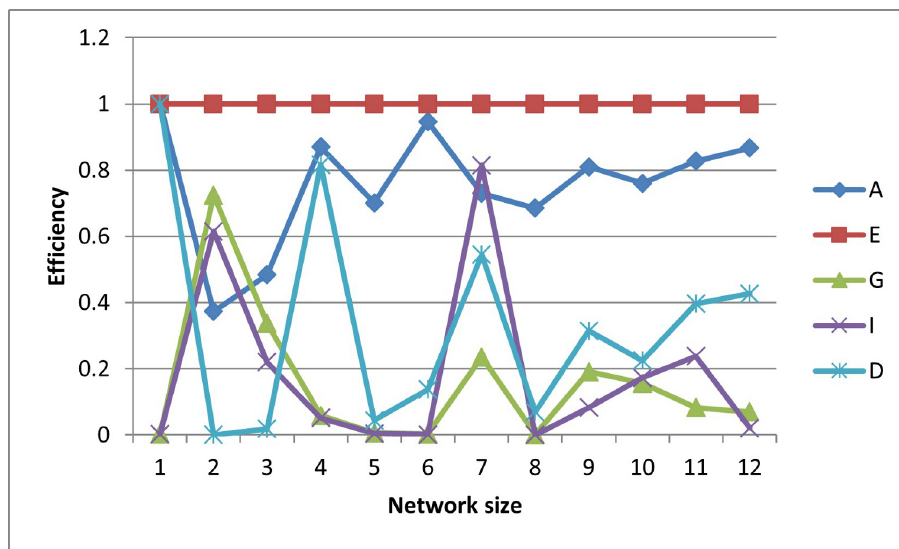
Fig 18. E-efficiencies of various optimal designs for the second case